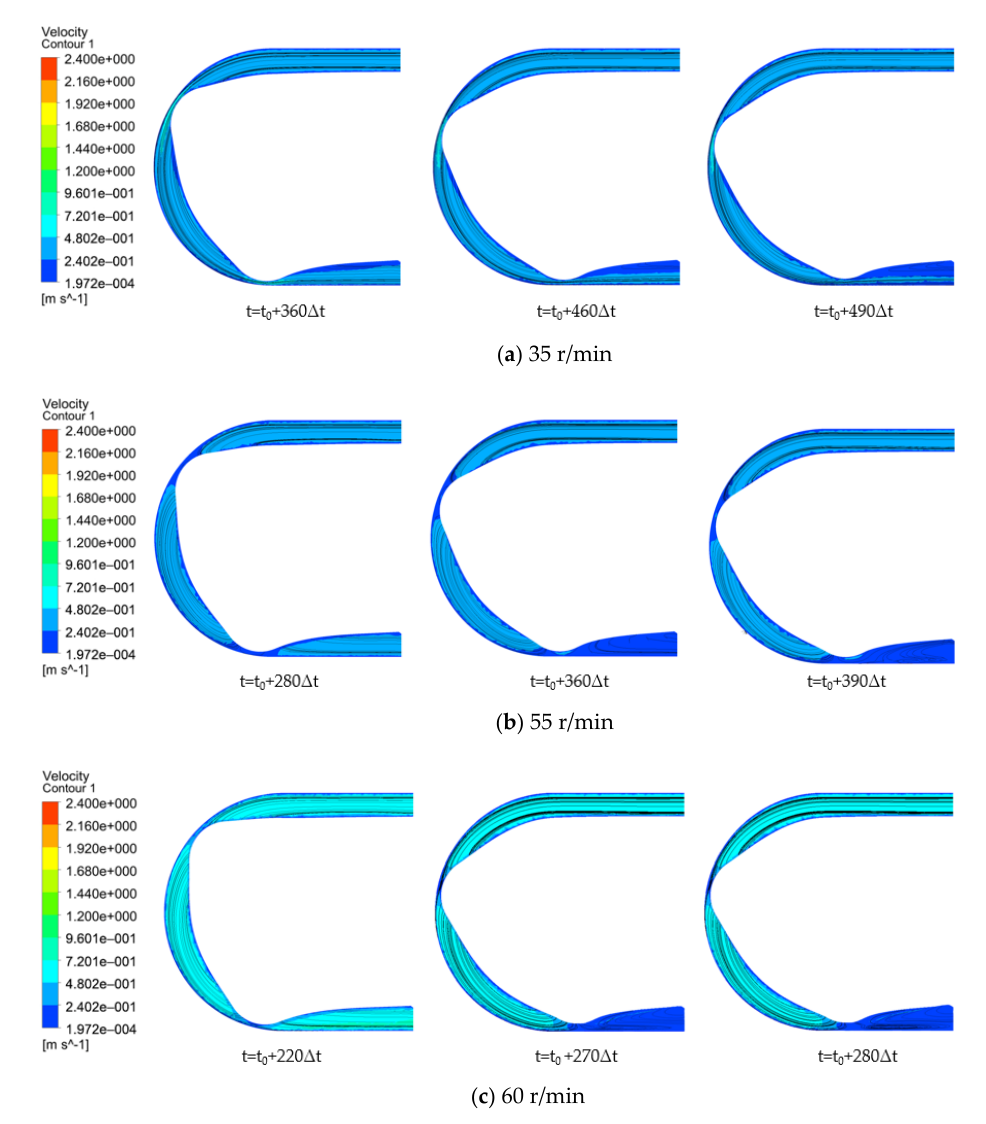
Figure 13. Flow line diagram at a 0.1 MPa outlet pressure at different speeds.